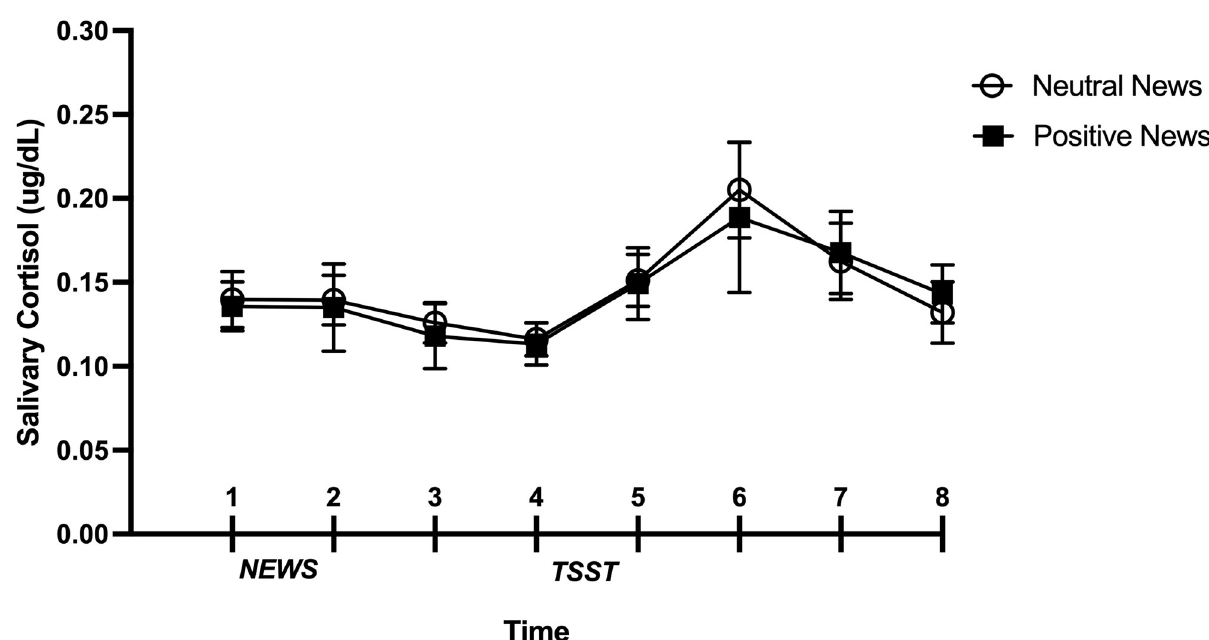
Fig 3. Salivary cortisol levels in response to news reading and TSST as a function of condition. Non-adjusted means of raw cortisol data were used in this graph and standard errors of the means were used for the error bars.